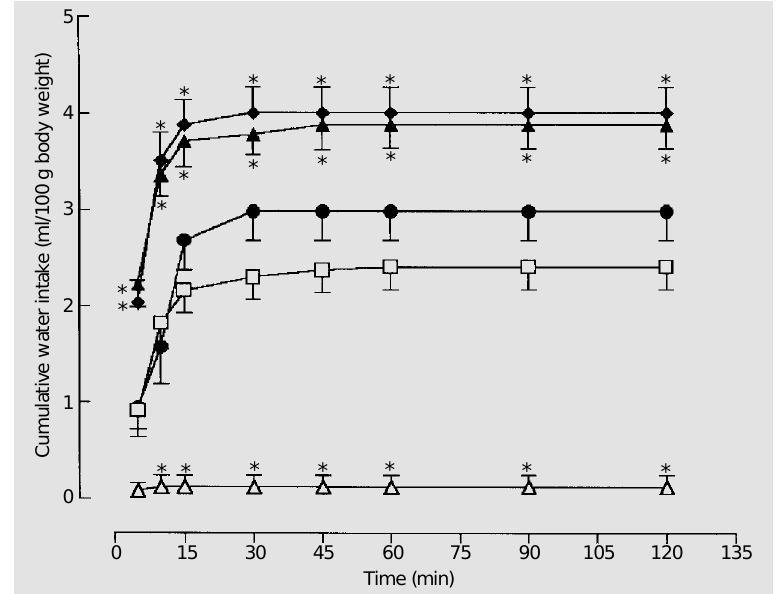
Figure 2. Cumulative water intake (ml/100 g body weight) in hypovolemic rats receiving third ventricle injections of saline (controls) or GR 113808 at different doses. The following groups are represented: hypovol + saline (squares; N = 12); hypovol + GR 20 nmol/rat (filled circles; N = 9); hypovol + GR 40 nmol/ rat (filled triangles; N = 9); hypovol + GR 80 nmol/rat (filled lozenges; N = 8). An additional group receiving subcutaneous injections of isotonic saline solution under the same conditions as used for PEG injection plus third ventricle injections of isotonic saline (normovol + saline, open triangles; N = 10) is also shown. Data are reported as means ± SEM. *P<0.05 compared to hypovol + saline (two-way analysis of variance followed by the Student-Newman-Keuls